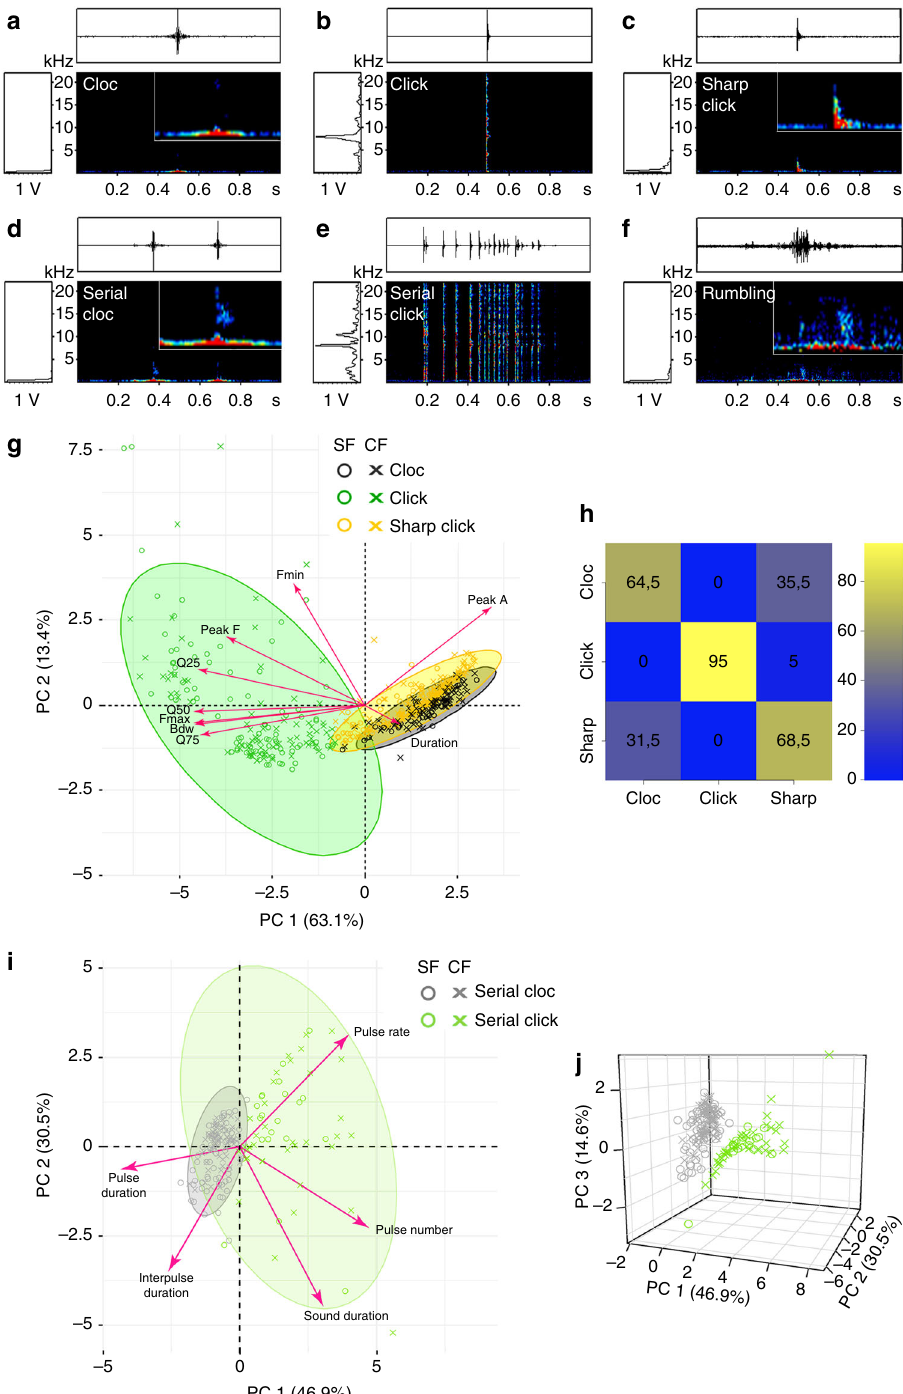
Fig. 1 A. mexicanus is a sonic species in the lab. a – f Representative sonograms of the 6 types of sounds identi fi ed. Magni fi cations (×3) on a 0.2 s window are provided as insets, to appreciate details of the sonogram for all sounds that do not spread to frequencies higher than 5 kHz (i.e., only Clicks are